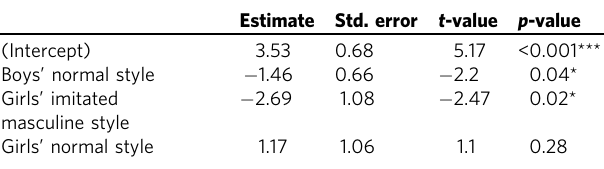
Table 13 Results of the linear-mixed-effects regression model for